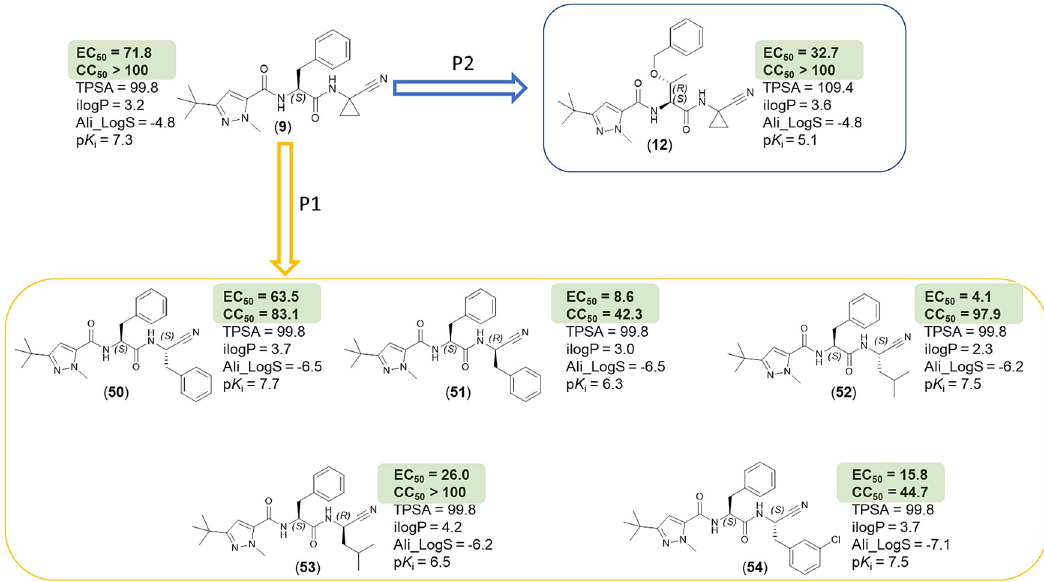
Fig 12. Schematic representation of physicochemical properties and SARs for trypanocidal activity. EC 50 calculated for amastigote forms of T . cruzi (Tuhaluen strain). CC 50 calculated for the LLCMK2 strain (host cell). Green areas highlight biochemical results. TPSA, ilogP, and Ali_Logs have been calculated with the swissADME online service [35]. p K i values are referring to Cz inhibition.